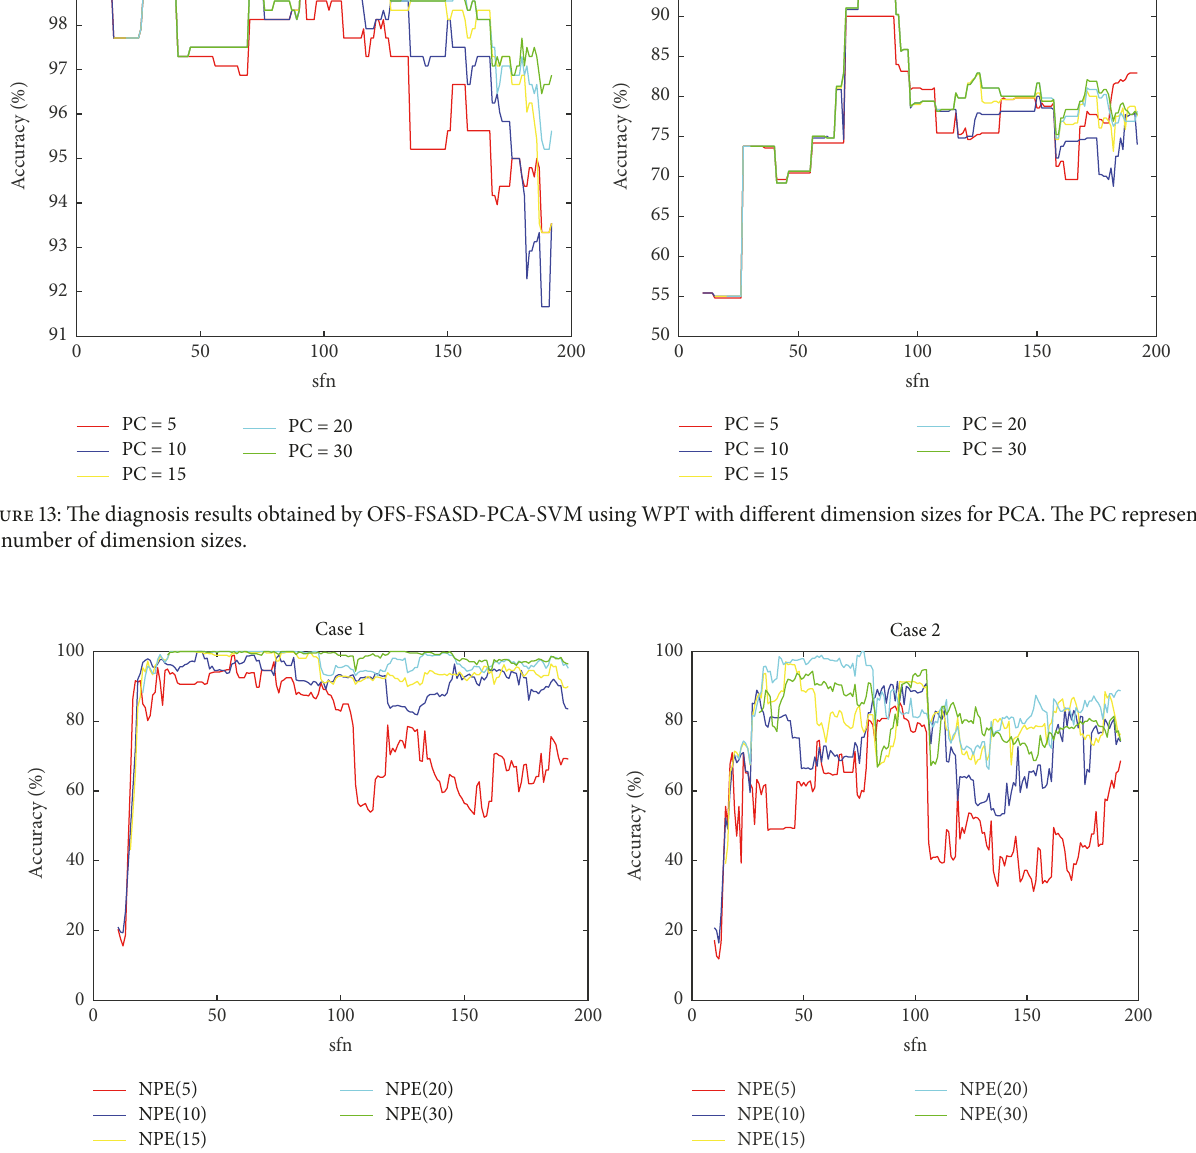
Figure 14: The diagnosis results obtained by OFS-FSASD-NPE-SVM using MODWPT with different dimension sizes for NPE. The NPE (5) represents that the number of dimension sizes is